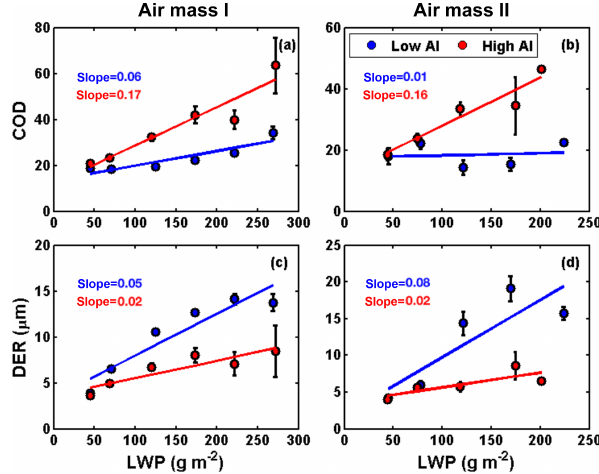
Figure 7. Liquid water path (LWP) and cloud droplet effective ra- dius (DER) as functions of lower tropospheric stability (LTS) at low (in blue) and high (in red) scattering aerosol index (AI) levels un- der cluster I air-mass ( a , c ) and cluster II air-mass ( b , d ) conditions. Low and high scattering AIs are defined as the lowest and highest quarter of all scattering AI samples, respectively.